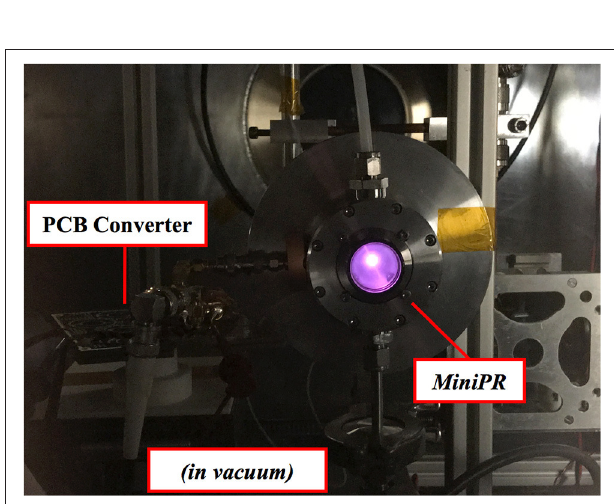
FIGURE 3 | Plasma testing in WOMBAT of the MiniPR thruster powered by the Converter PCB, both in vacuum.